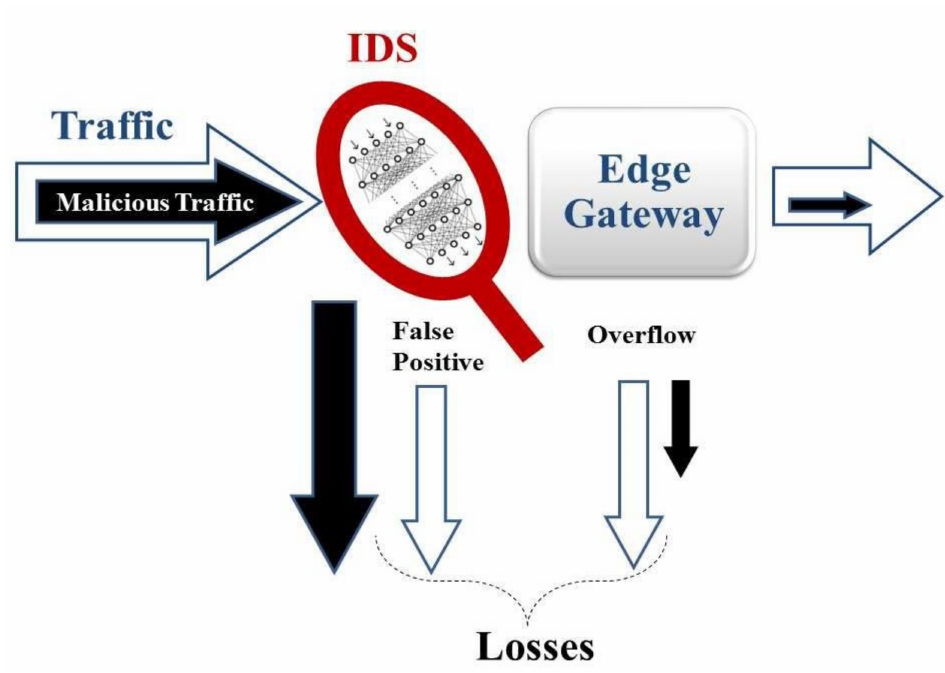
Figure 1. Losses of legitimate users due to the use of an